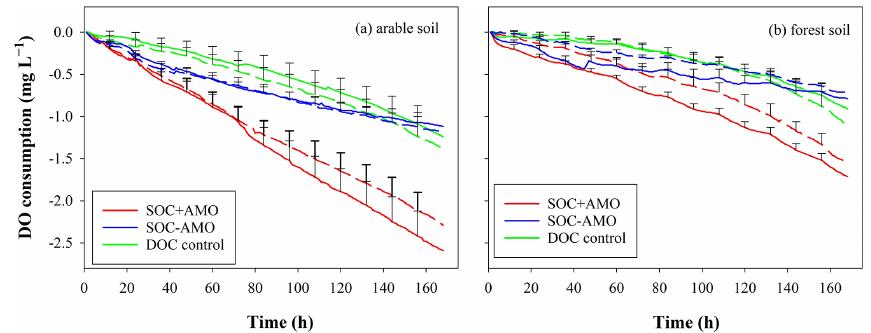
Figure 3. DO consumption of the SOC + AMO treatment (red), the SOC − AMO treatment (blue), and the DOC control treatment (green) during the incubations, under rotating (full lines) and stationary (dashed lines) conditions: (a) incubation with arable soil, (b) incubation with forest soil. Standard errors were calculated based upon six repetitions with different river water samples.